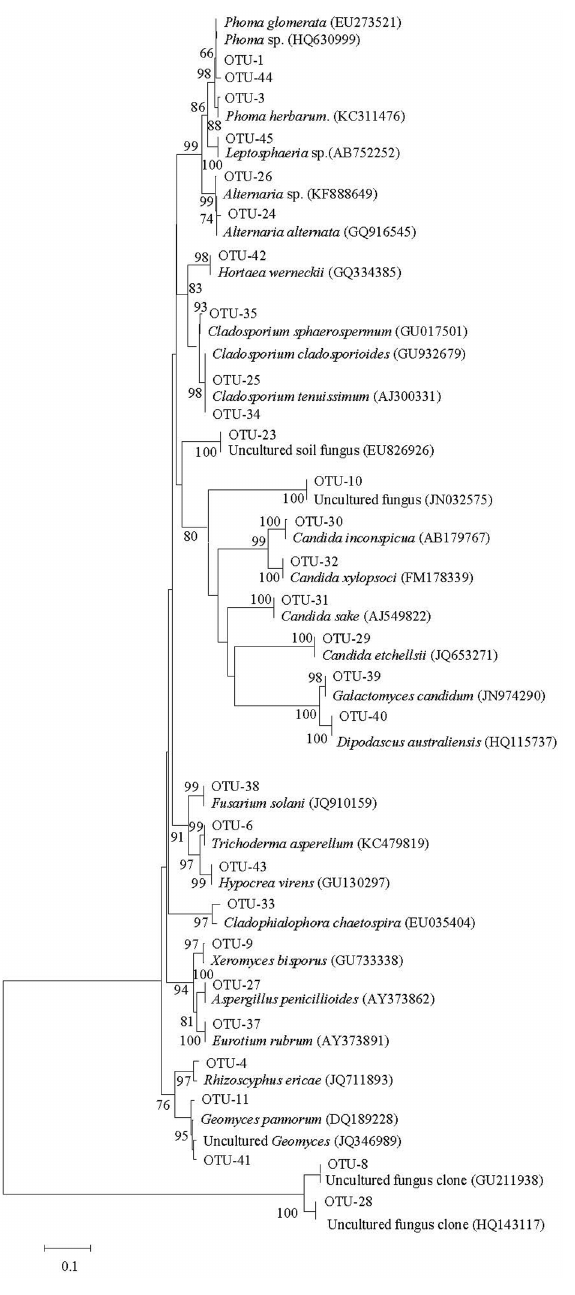
Figure 1. Neighbor-joining phylogenetic tree from analysis of ITS rDNA from 29 Ascomycota representative sequences in five libraries. The numbers at the nodes are the percentages indicating the level of bootstrap support based on a neighbor-joining analysis of 1000 resampled data sets. Only values . 50% are shown. The scale bar represents 0.1 substitutions per nucleotide position.